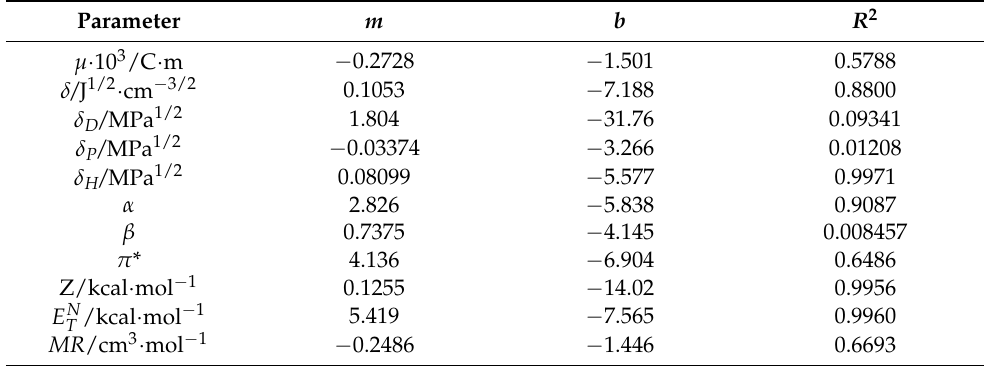
Table 5. Slope ( m ), y intercept ( b ), and correlation coefficient ( R 2 ) of the parameters considered.